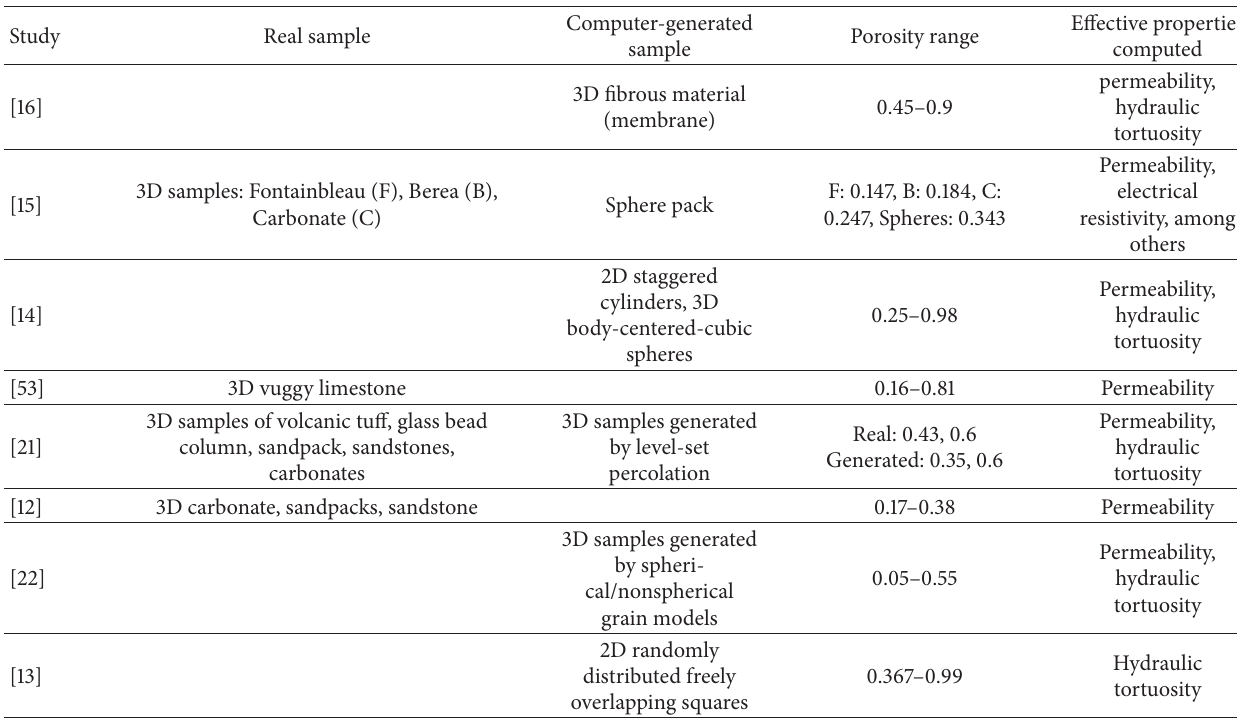
Table 1: Recent work using real or computer-generated porous media samples: comparison of sample types, porosities, and computed